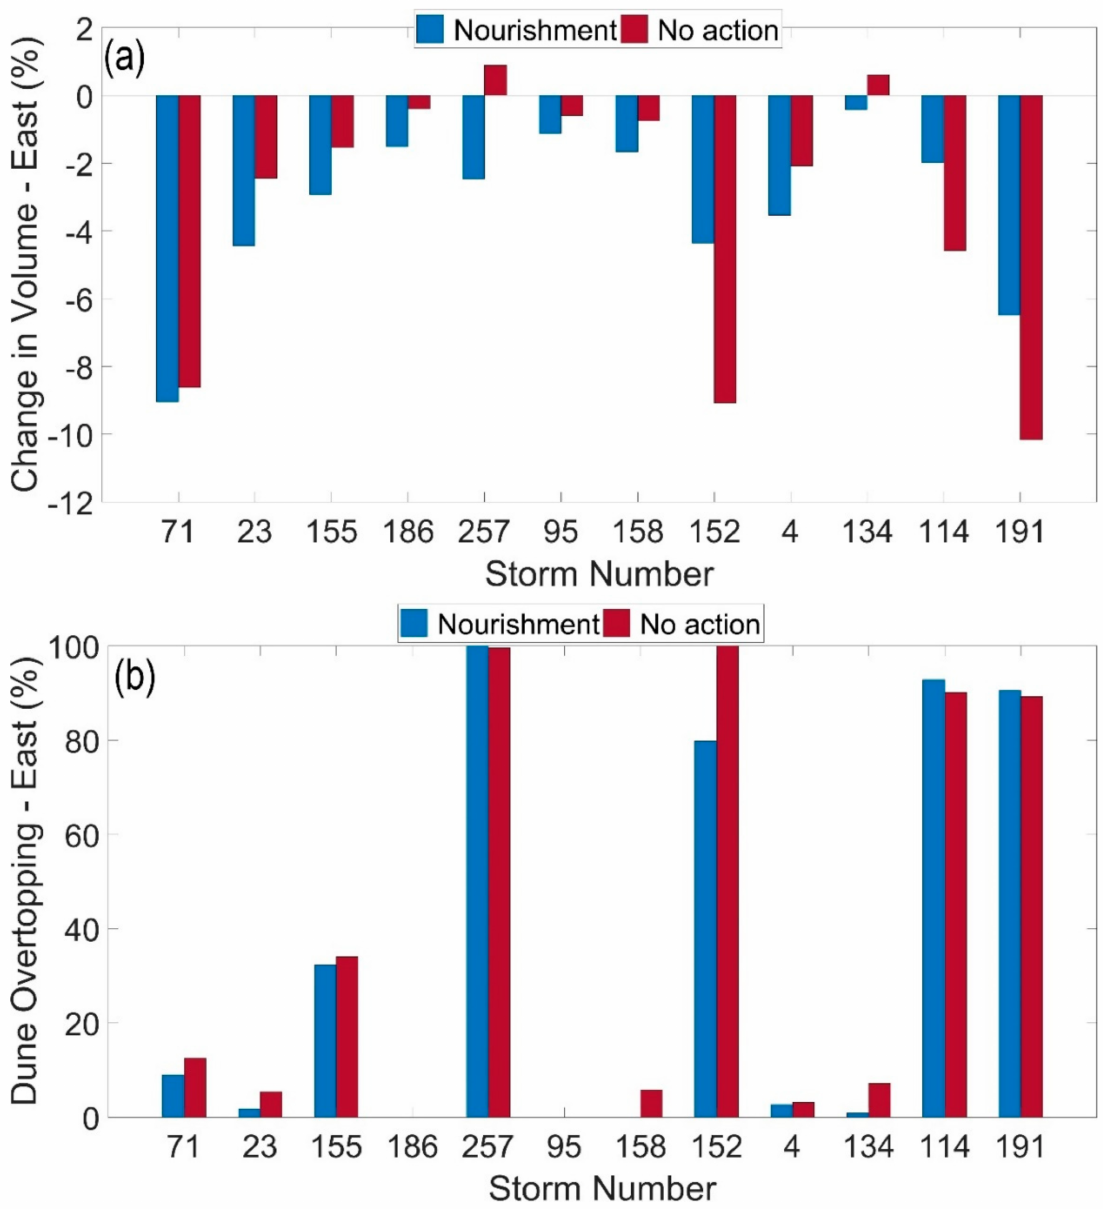
Figure 4. For each storm the ( a ) percent change in subaerial island volume east of Katrina Cut and ( b ) the percent of dunes overtopped east of Katrina